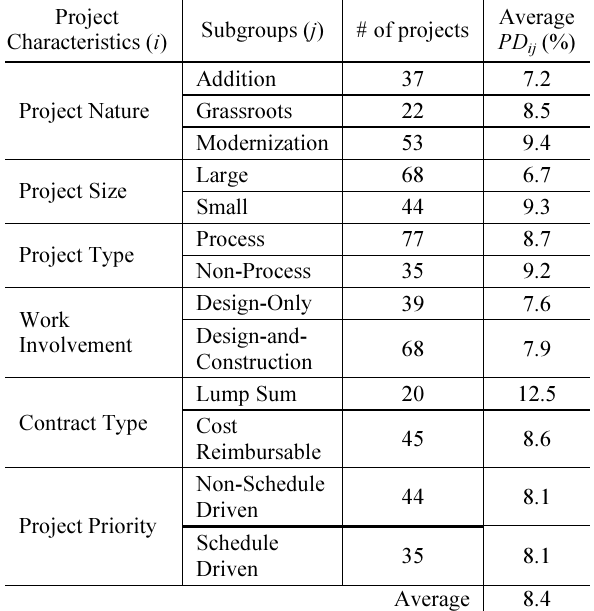
Table 4. Average percentile difference (PD) by project charac-